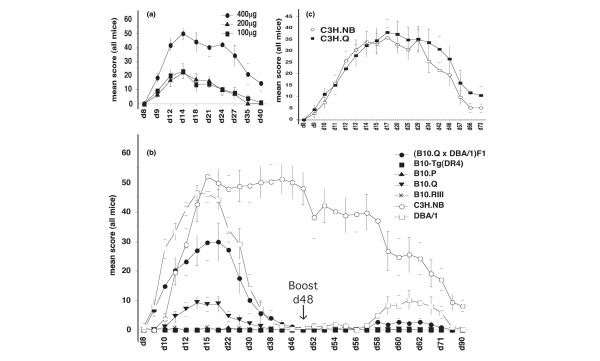
Characterization of G6PI-induced arthritis. Shown are characteristics of glucose-6-phosphate isomerase (G6PI)-induced arthritis in different genetic backgrounds and major histocompatibility complex (MHC) congenics. (a) DBA/1 mice were immunized intradermally at the base of the tail with the indicated amounts of G6PI emulsified in complete Freund's adjuvant (CFA) to establish a dynamic immunization protocol allowing for an increase or decrease in disease severity. The course of disease was followed for 40 days after immunization. The graph shows the mean scores for all mice. Disease developed in 8/8 (400 μg/mouse), 9/9 (200 μg/mouse) and 8/9 (100 μg/mouse) mice. (b) After establishing the immunization protocol, mice with different MHC haplotypes and genetic backgrounds were immunized with 200 μg G6PI in CFA at the base of the tail. Active arthritis, characterized by redness and oedema, was scored over 90 days after immunization. Blood was drawn at day 40 for antibody analysis and the mice were boosted with human G6PI (50 μg/mouse in incomplete Freund's adjuvant) at day 48. The numbers of mice of each strain evaluated were as follows: (B10.Q × DBA/1)F1, n = 10; B10-Tg(DR4), n = 8; B10.P, n = 12; B10.Q, n = 26; B10.RIII, n = 6; C3H.NB, n = 9; and DBA/1, n = 10. (c) Because the MHC haplotype H-2p on the black background rendered mice resistant to G6PI-induced arthritis, the role of the beta chain of Ap was addressed on the highly susceptible C3H background. C3H.NB (H-2p; n = 21) and C3H.Q (H-2q; n = 19) mice were immunized intradermally with 200 μg G6PI in CFA and scored for 73 days. At no time point was a significant difference noticed between the two MHC congenic strains. Only a tendency toward more chronic progression could be seen in the C3H.Q mice during the late phase. In all experiments, error bars indicate the standard error of the mean.